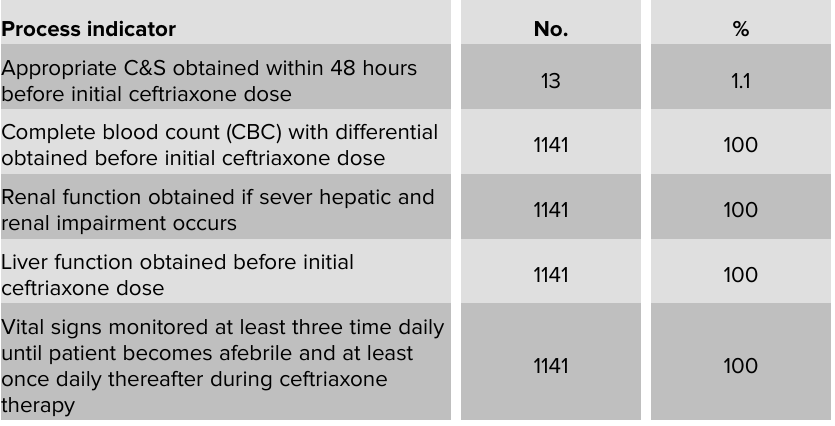
Table 3: Process indicators of ceftriaxone encounters (total of 1141).